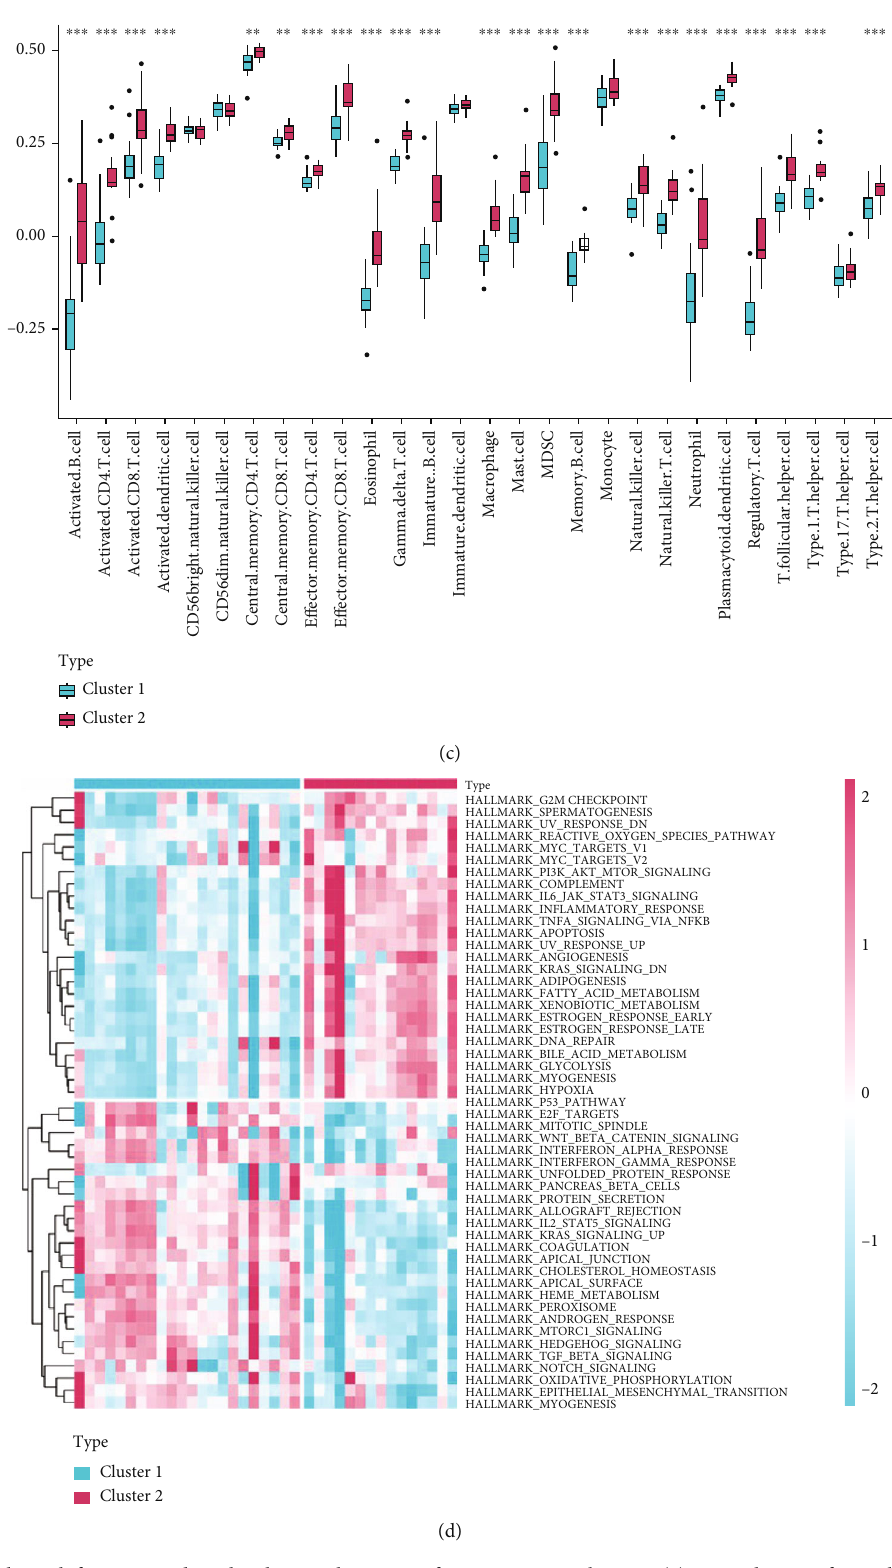
Figure 7: Immunological features and molecular mechanisms of IC immune subtypes. (a) Box plots perform the expression of IC characteristic genes in IC immune subtypes. (b) Box plots perform the expression of immune checkpoint-related genes in IC immune subtypes. (c) Box plots perform the abundance of 28 in fi ltrated immune cells evaluated by ssGSEA in IC immune subtypes. (d) The heatmap shows the enrichment levels of hallmark gene sets in IC immune